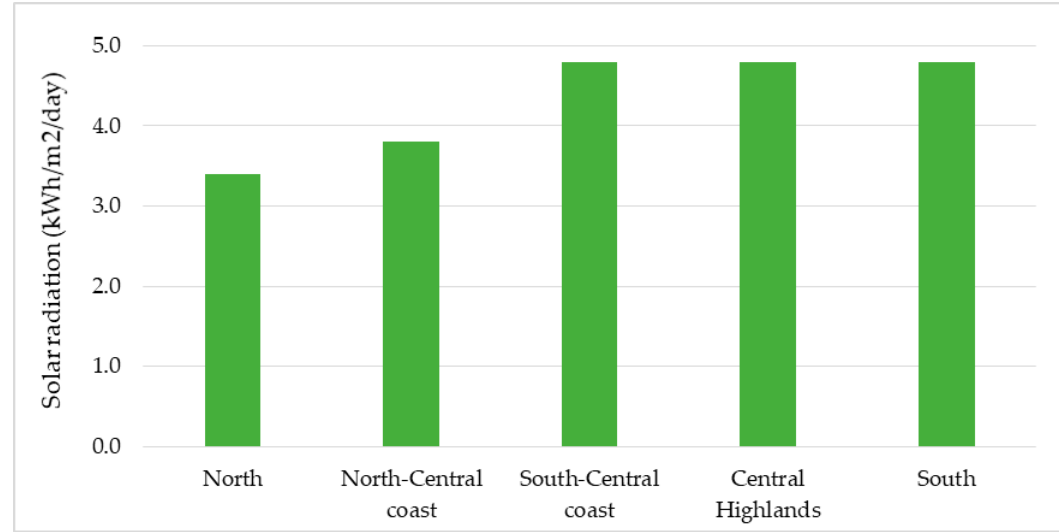
Figure 5. Chart of annual average of daily GHI by CIEMAT&MoIT.